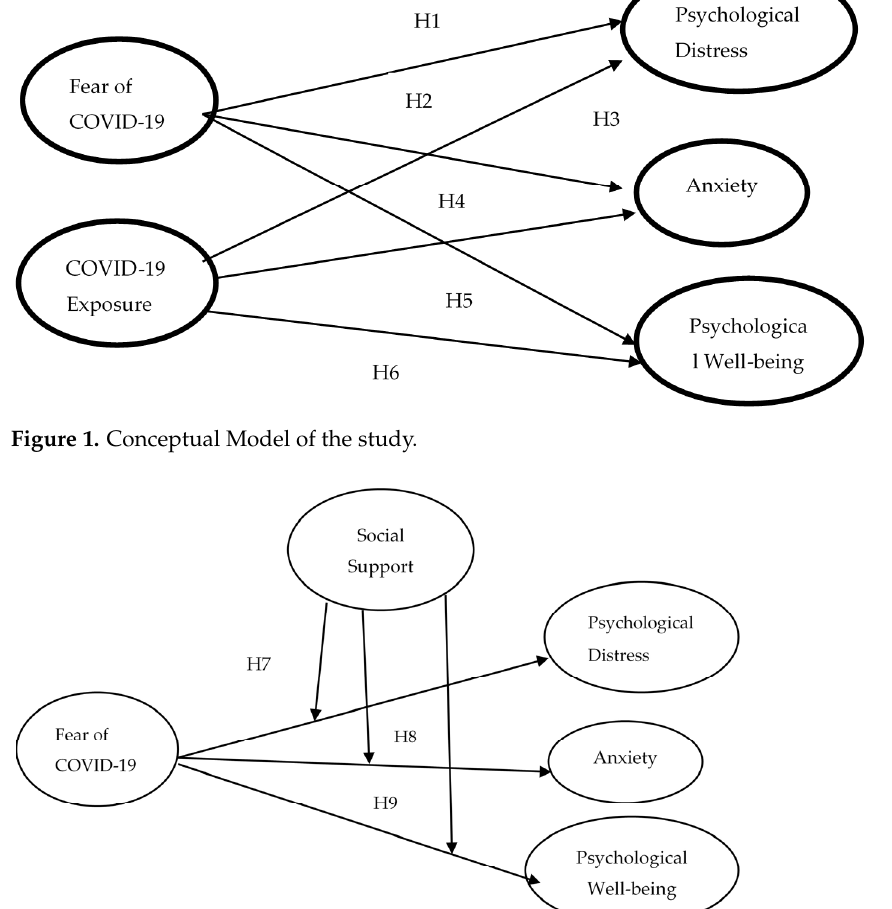
Figure 2. Moderation Model of the study (Fear of COVID-19 and mental health).